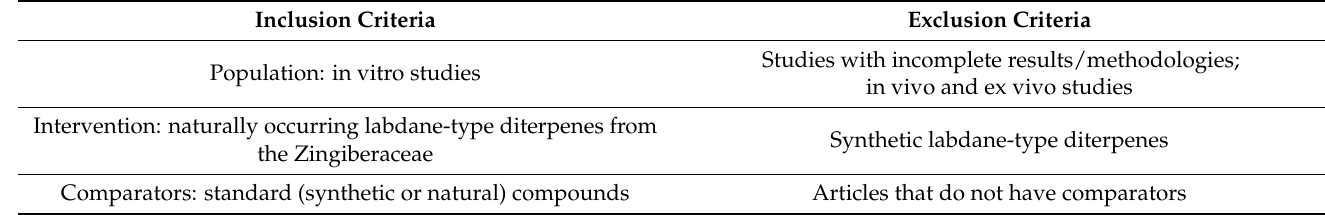
Table 2. Inclusion and exclusion